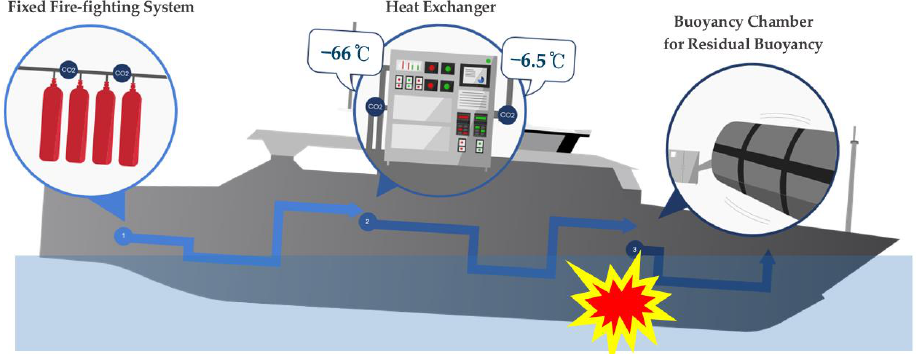
Figure 1. Concept of the BSS [1].